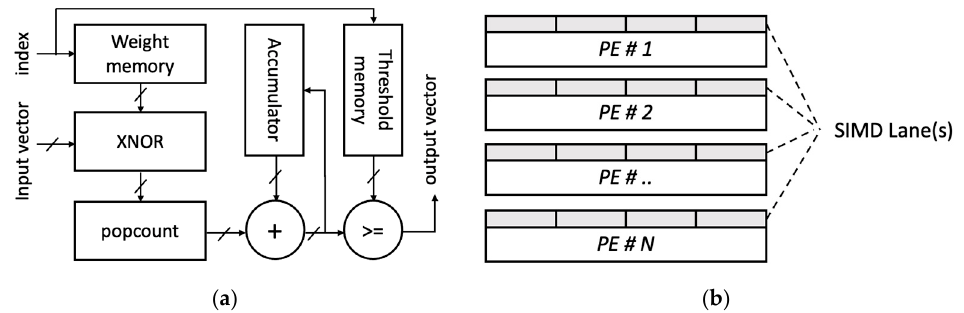
Figure 11. PE and SIMD architecture ( a ) PE architecture, ( b ) SIMD lanes. Table 2. PE and SIMD configuration.